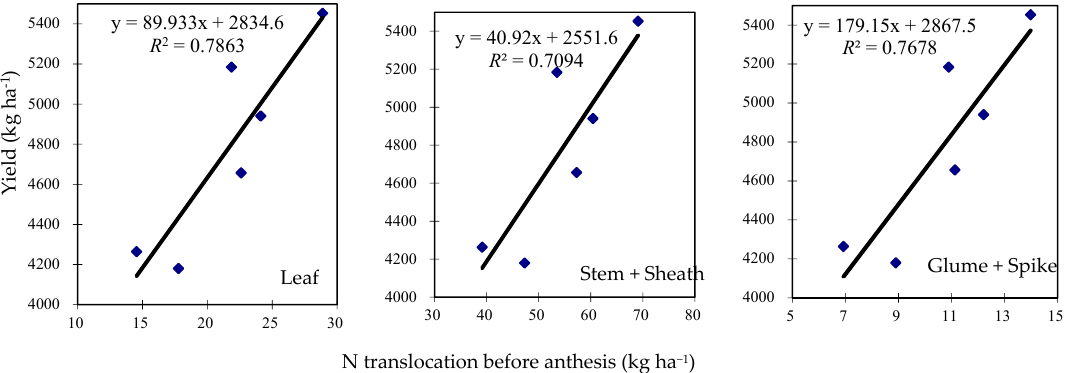
Figure 3. Relationship of yield with nitrogen translocation before anthesis (2013–2014), solid lines are linear regressions, dashed lines are the 95% confidence intervals.